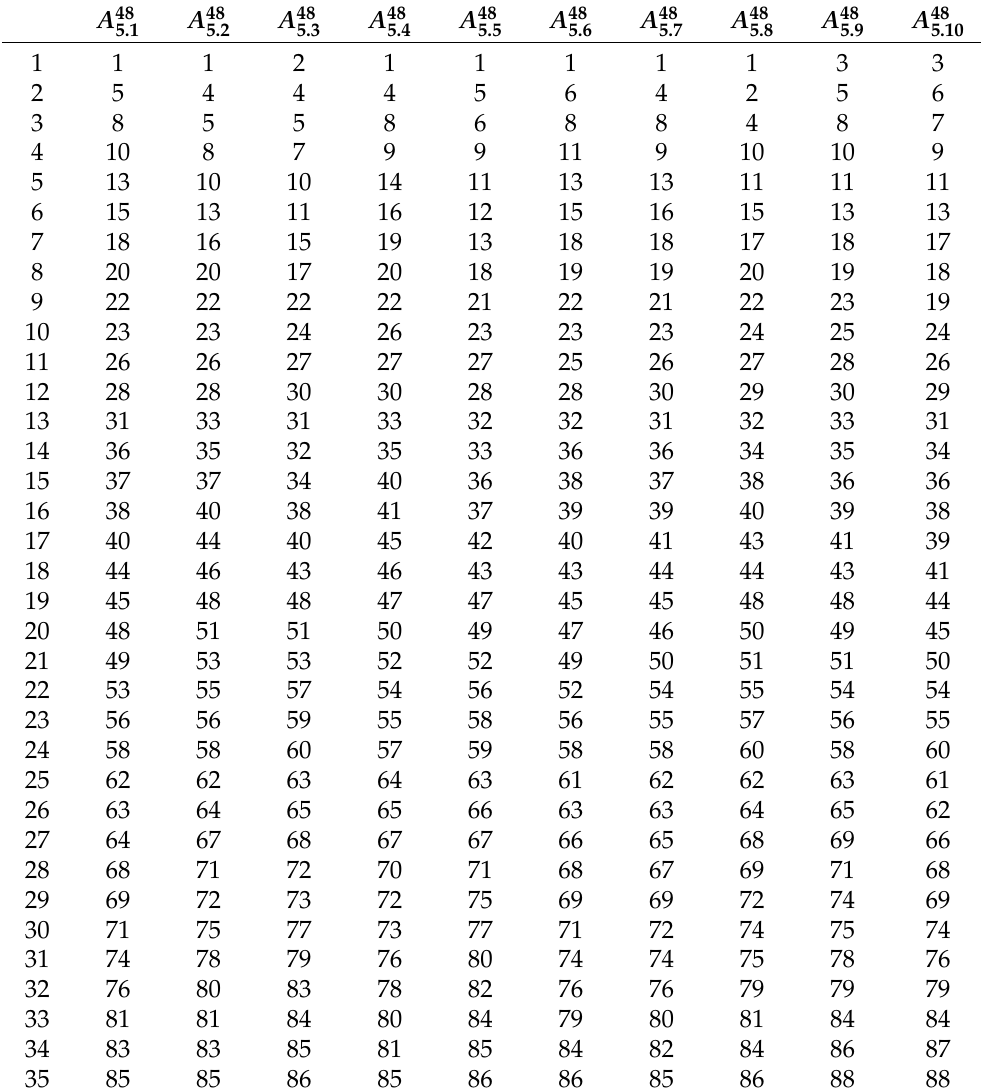
Table A2. Row numbers of ten non-isomorphic